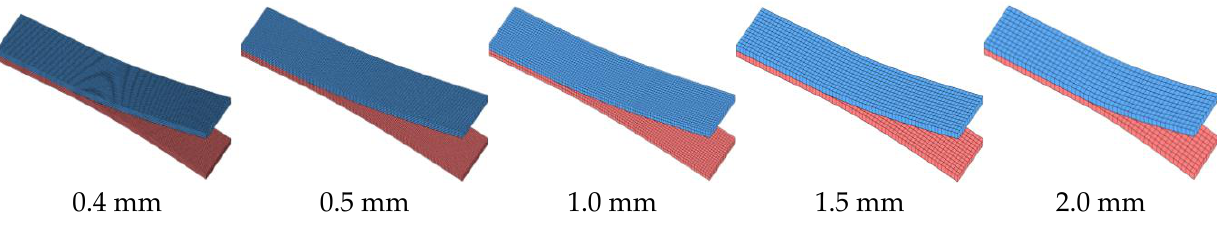
Figure 4. Model I with different element